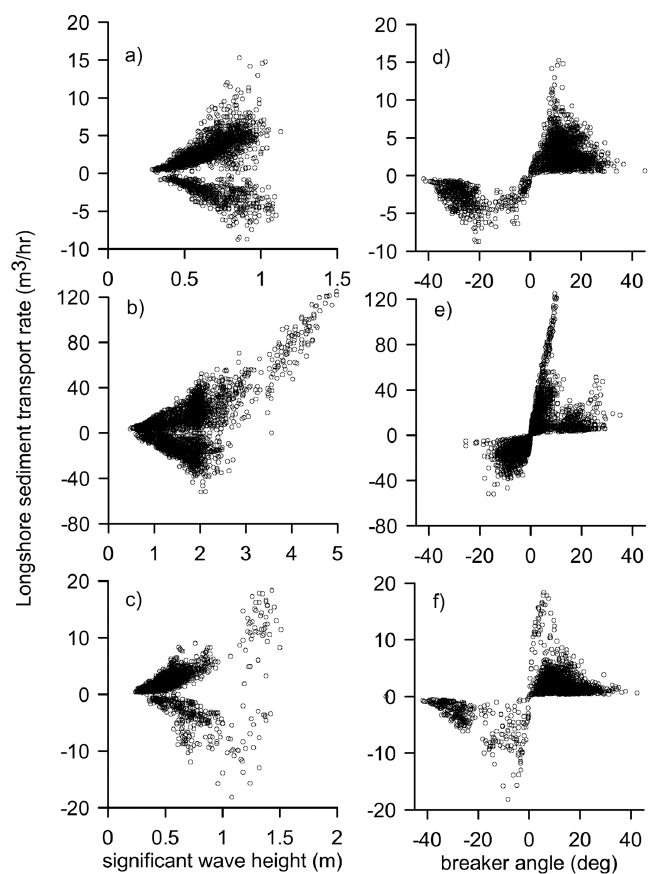
Figure 8. Influence of wave breaker height on the LSTR ( a – c ) and wave breaker angle on LSTR ( d – f ) in different seasons from September 2014 to August 2015. ( a ) and ( d ) pre ‐ monsoon (February–May), ( b ) and ( e ) monsoon (June–September) and ( c ) and ( f ) post ‐ monsoon (October–January).